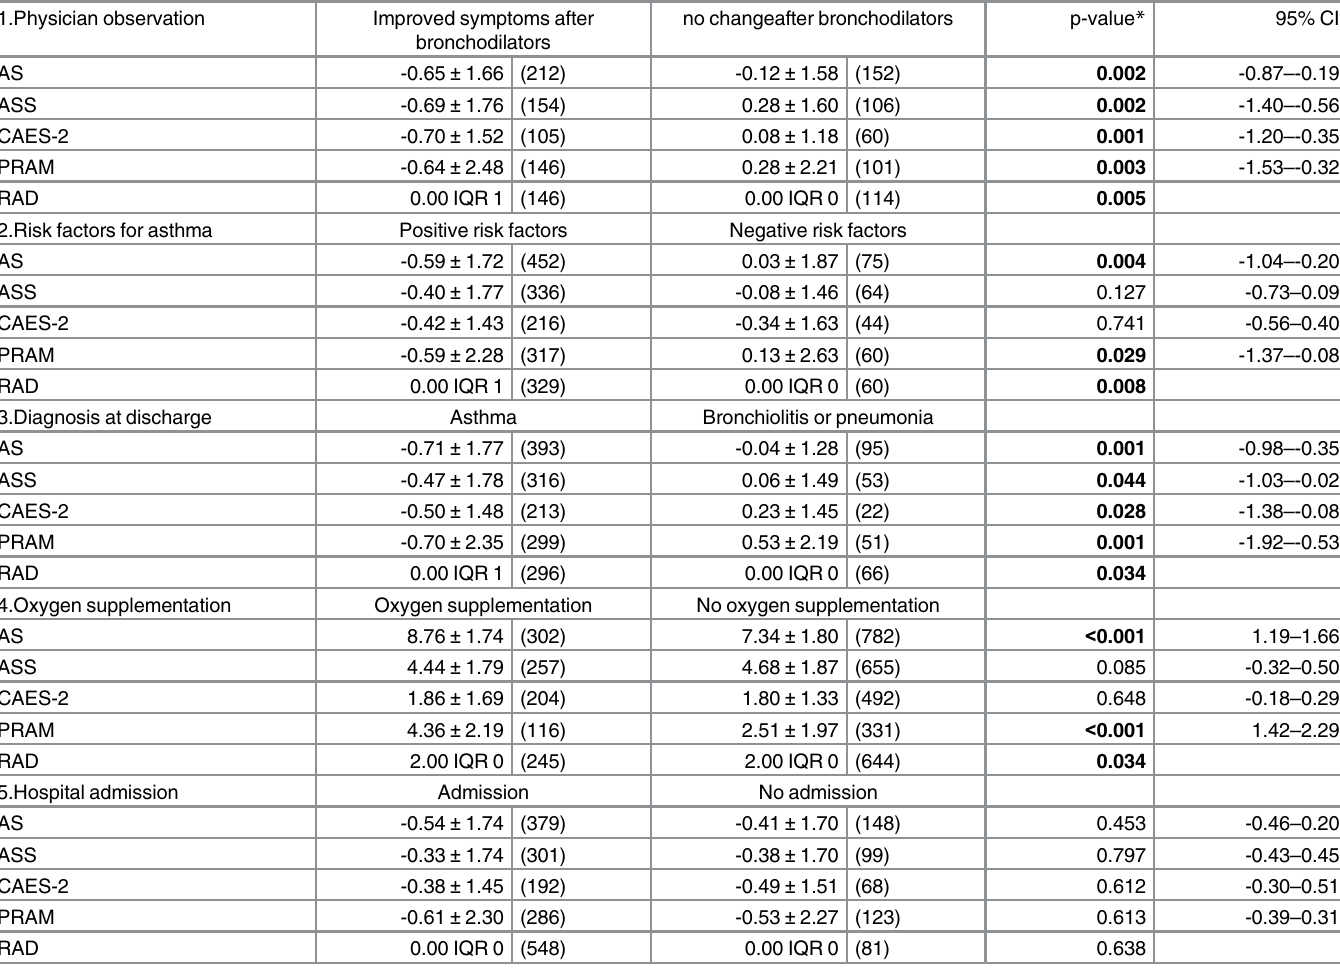
Table 2. Construct validity of five dyspnoea scores by testing difference between subgroups in five predefined